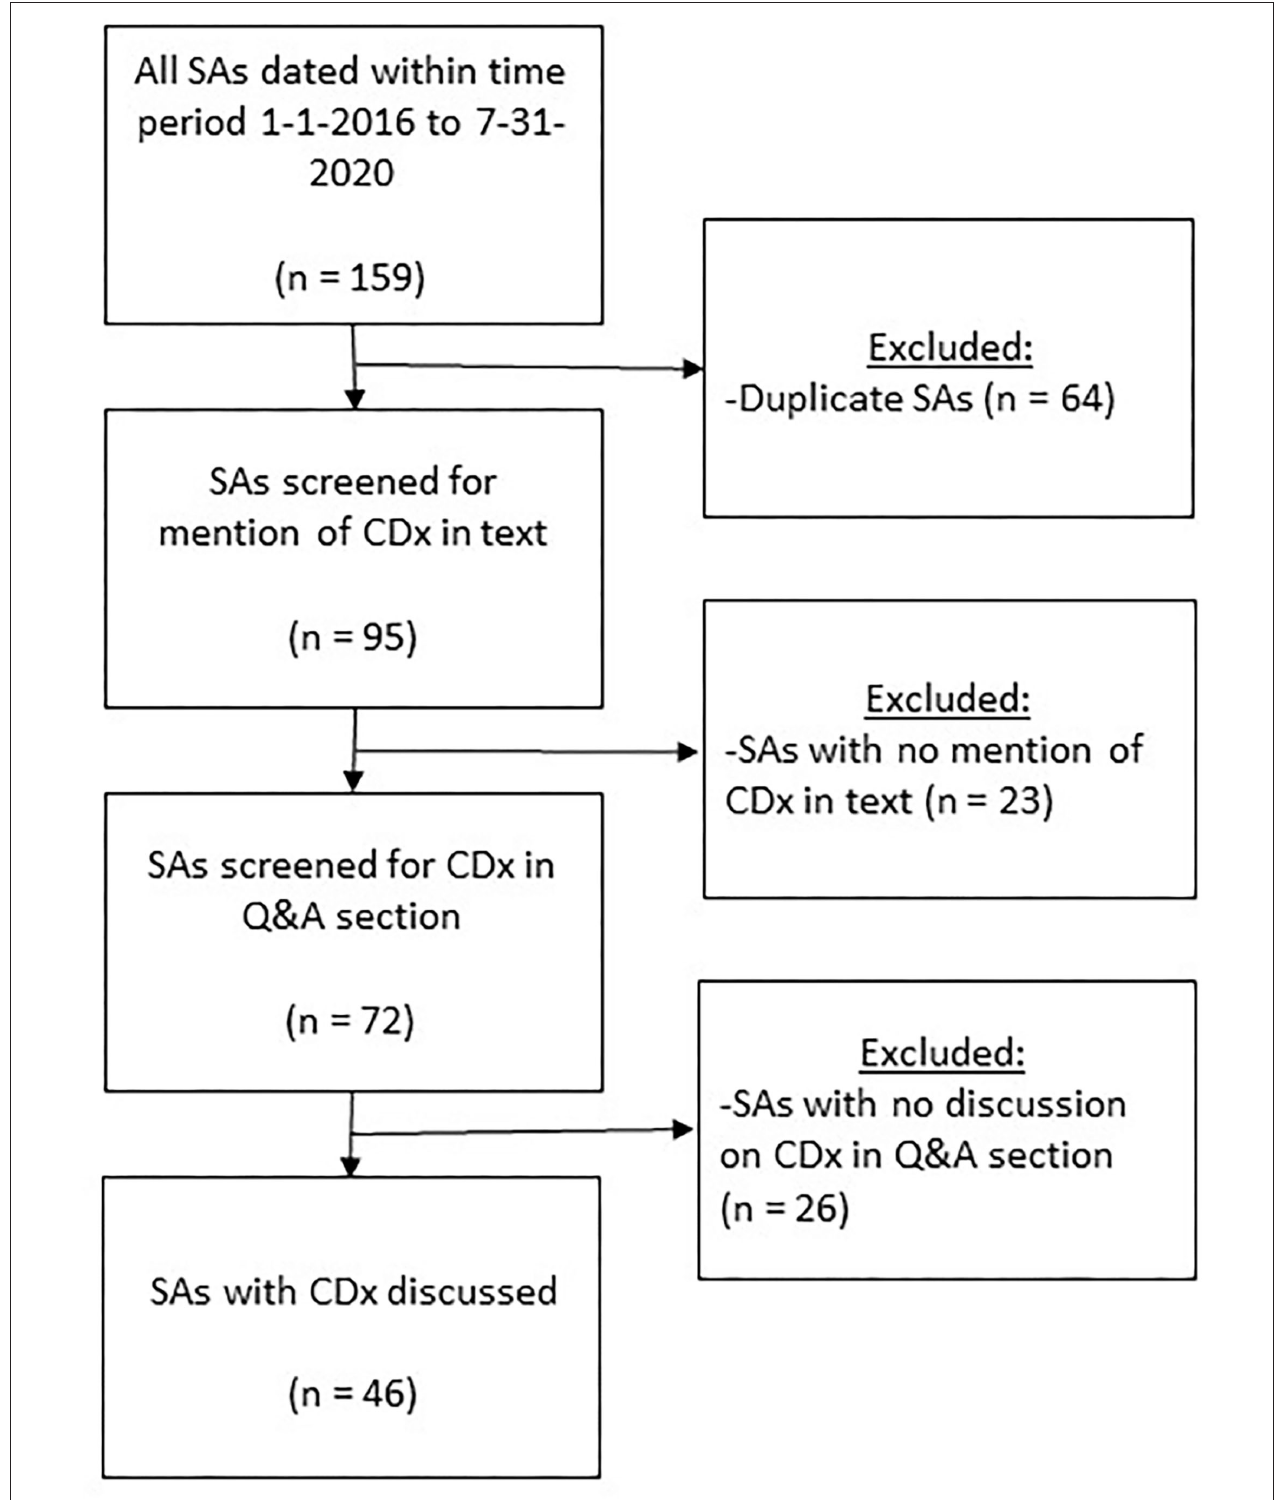
FIGURE 3 | Flowchart visualizing the selection of medicines with CDx involved, and discussed in the question-and-answer section in scientific advice reports provided by the EMA in January 2016–July 2020. CDx, companion diagnostics; Q&A, question and answer; SA, scientific advice.